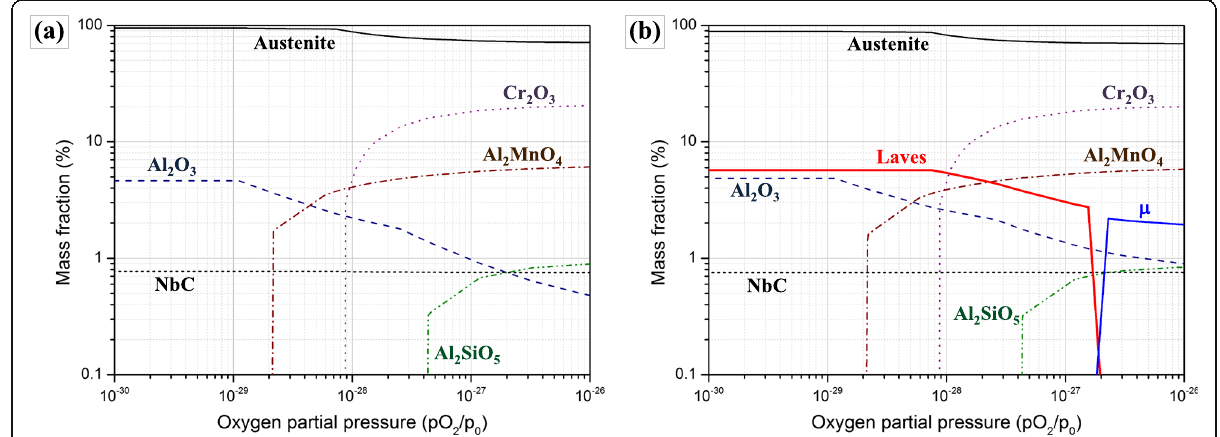
Fig. 8 Phase equilibria at 1053 K according to oxygen partial pressure: a W0, b